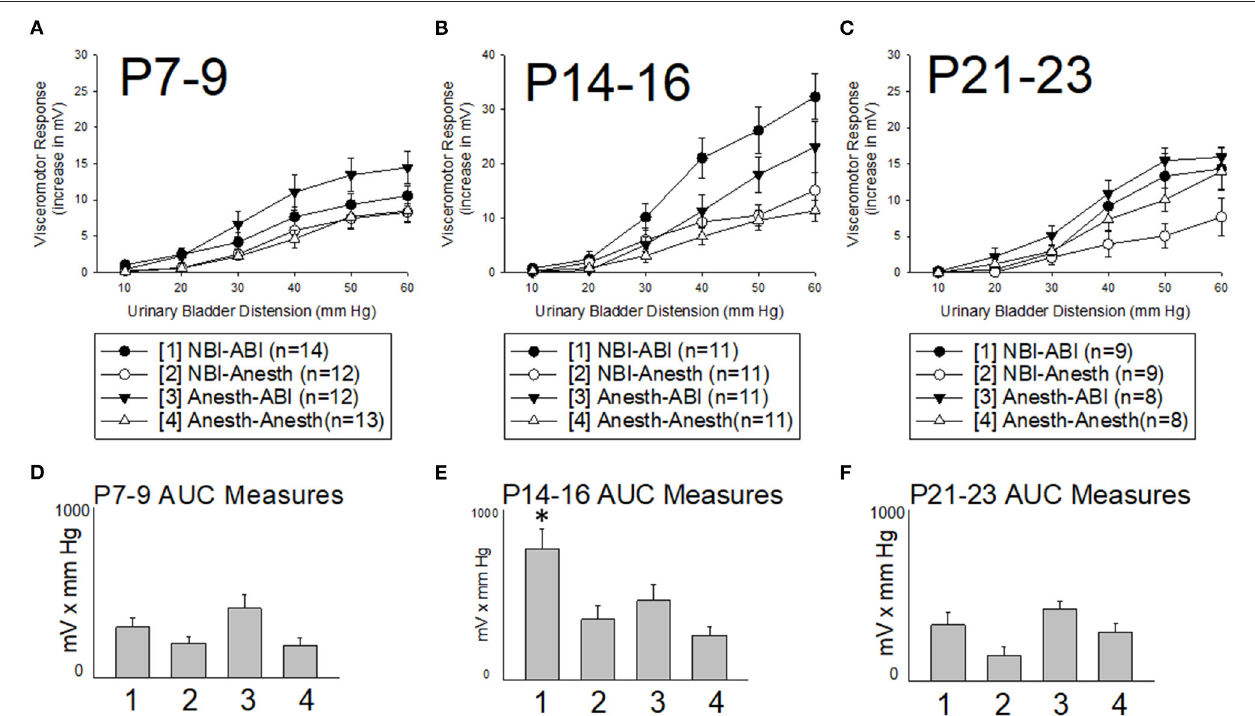
FIGURE 3 | Effect of Timing of Neonatal Treatments on Visceromotor Responses as Adults. All panels are labeled by their 3 days of postnatal treatment as pups [P7-9, (A,D) ; P14-16, (B,E) ; P21-23, (C,F) ] with either intravesical zymosan producing neonatal bladder inflammation (NBI treatment) or with control treatments (Anesth treatment). One day prior to study, adults rats received either retreatment with intravescial zymosan producing acute adult bladder inflammation (-ABI treatment) or with control treatments (-Anesth treatment). All rats received a combination of an adult and a neonatal treatment as labeled. Y-axis in (A–C) indicate the vigor of the visceromotor responses measured as increases in abdominal electromyographic activity evoked by the intensities of urinary bladder distension indicated in the x-axis. (D–F) indicate Area-Under-the-Curve (AUC) measures for the stimululs-response functions in the main panels–pretreatment groups are indicated numerically as per the legend box. Although ABI produced statistically significant increases in visceromotor activity with treatment at all three timepoints, only treatment at the P14-16 timepoint led to an increase in responses of adult rats in the NBI-ABI group when compared with the Anesth-ABI group. Data is presented as means ± SEM. N’s and treatment groups are as indicated in legend boxes. * in (E) indicates statistically significant difference from the other three groups with p <